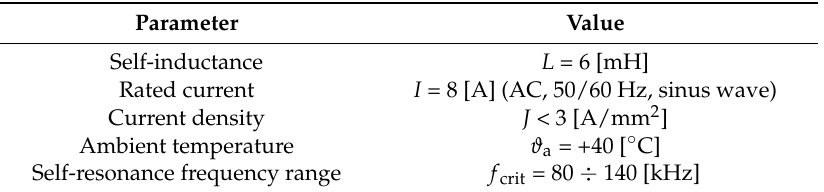
Table 1. Technical parameters required for the filter.